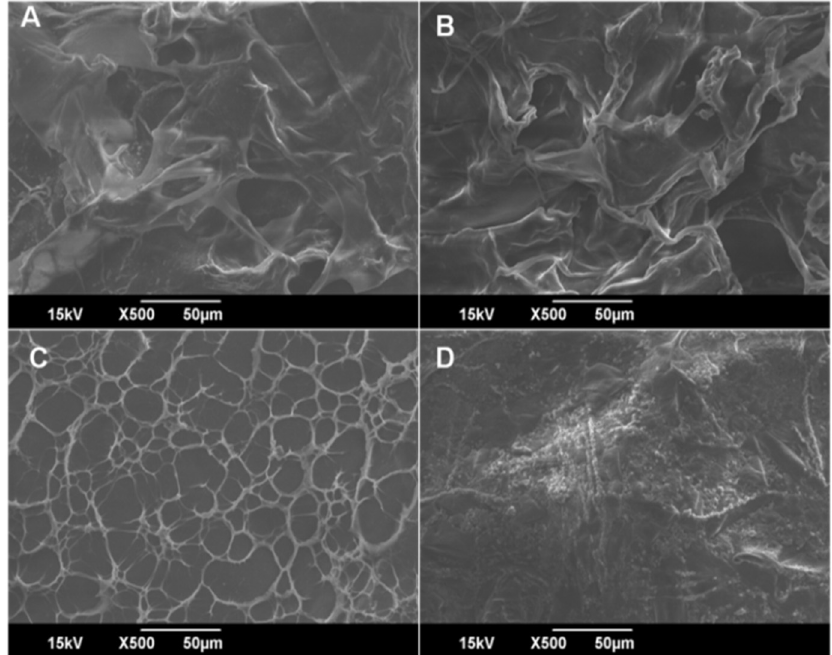
Figure 4. Scanning electron microscopy (SEM) images of ( A ) CH scaffolds (Cp) ( B ) CH plasticized scaffolds (Cp1) ( C ) CH plasticized- and surfactant-added scaffolds (Cp2); ( D ) Cp2+0.0025 AgNPs (Cp6).